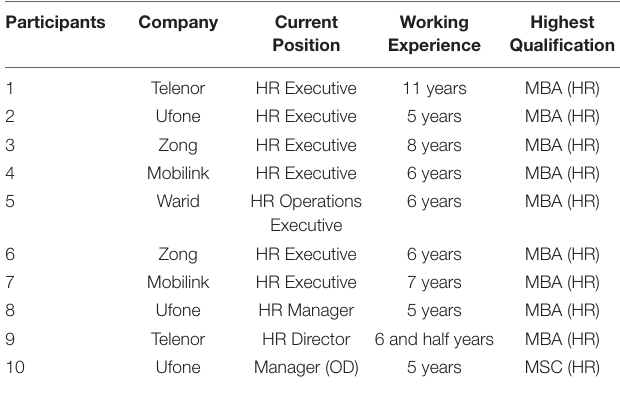
TABLE 1 | Demographic information of the